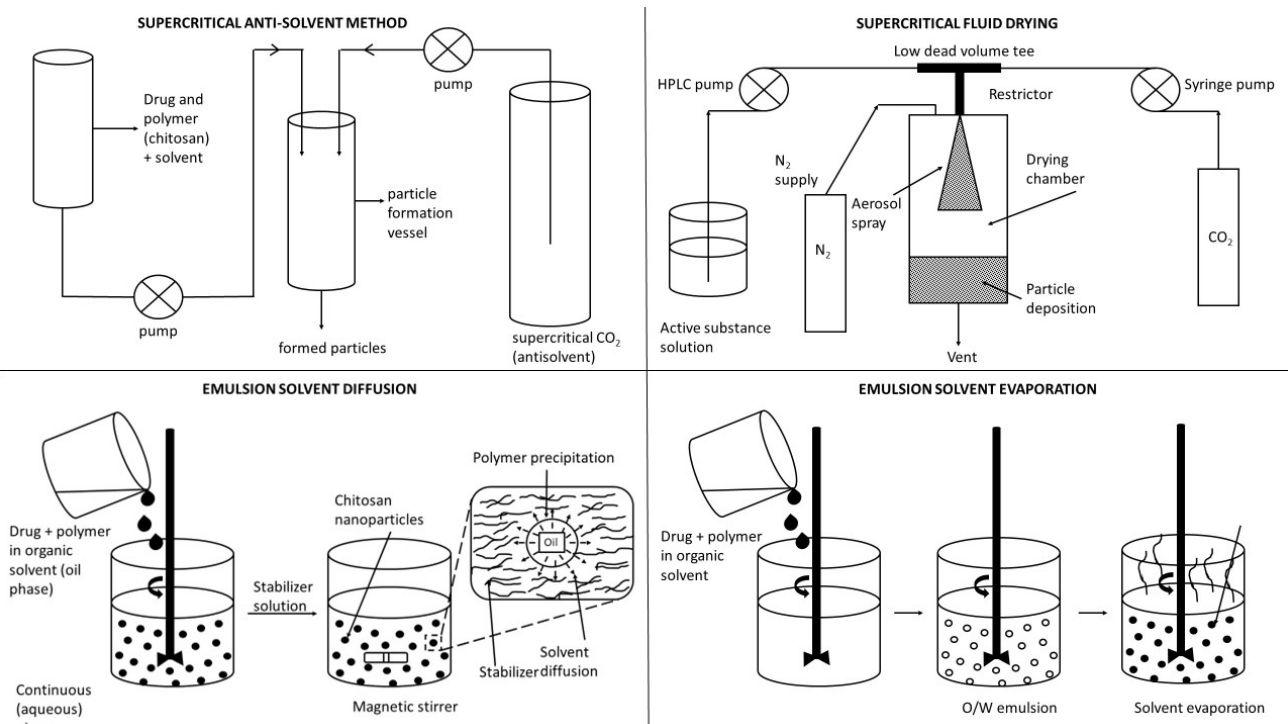
Figure 12. Schematic representation of preparation methods of CS NPs applied for antivirals.